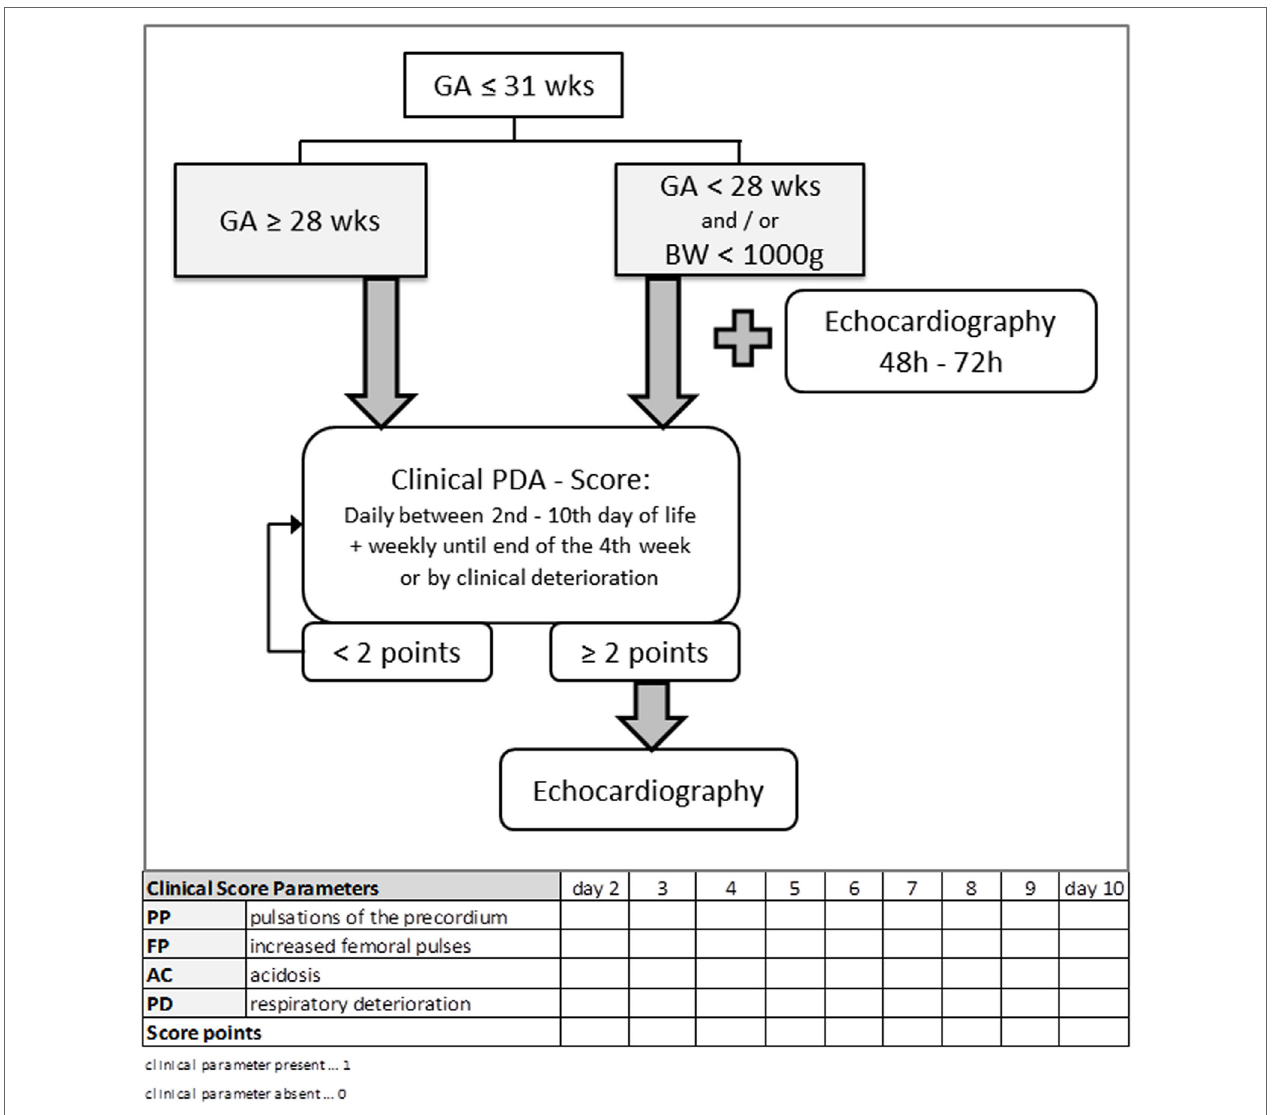
FigUre 1 | Flowchart of the clinical approach to diagnose a clinical relevant hemodynamically significant persistent ductus arteriosus (hsPDA) using clinical parameters and echocardiography. The scoring tool was used in all premature neonates equal or less than 31 weeks of gestation. In all preterm infants GA < 28 weeks or BW < 1,000 g, an initial echocardiography was performed between 48 and 72 h of life, in addition to the clinical score. All other premature neonates GA ≥ 28 weeks were assessed by clinical scoring and received an echocardiography only if the score was ≥ 2 points. GA, gestational age; BW, birth